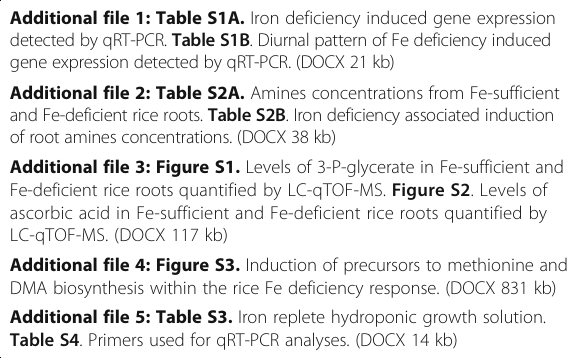
Additional file 4: Figure S3. Induction of precursors to methionine and DMA biosynthesis within the rice Fe deficiency response. (DOCX 831 kb) Additional file 5: Table S3. Iron replete hydroponic growth solution. Table S4 . Primers used for qRT-PCR analyses. (DOCX 14